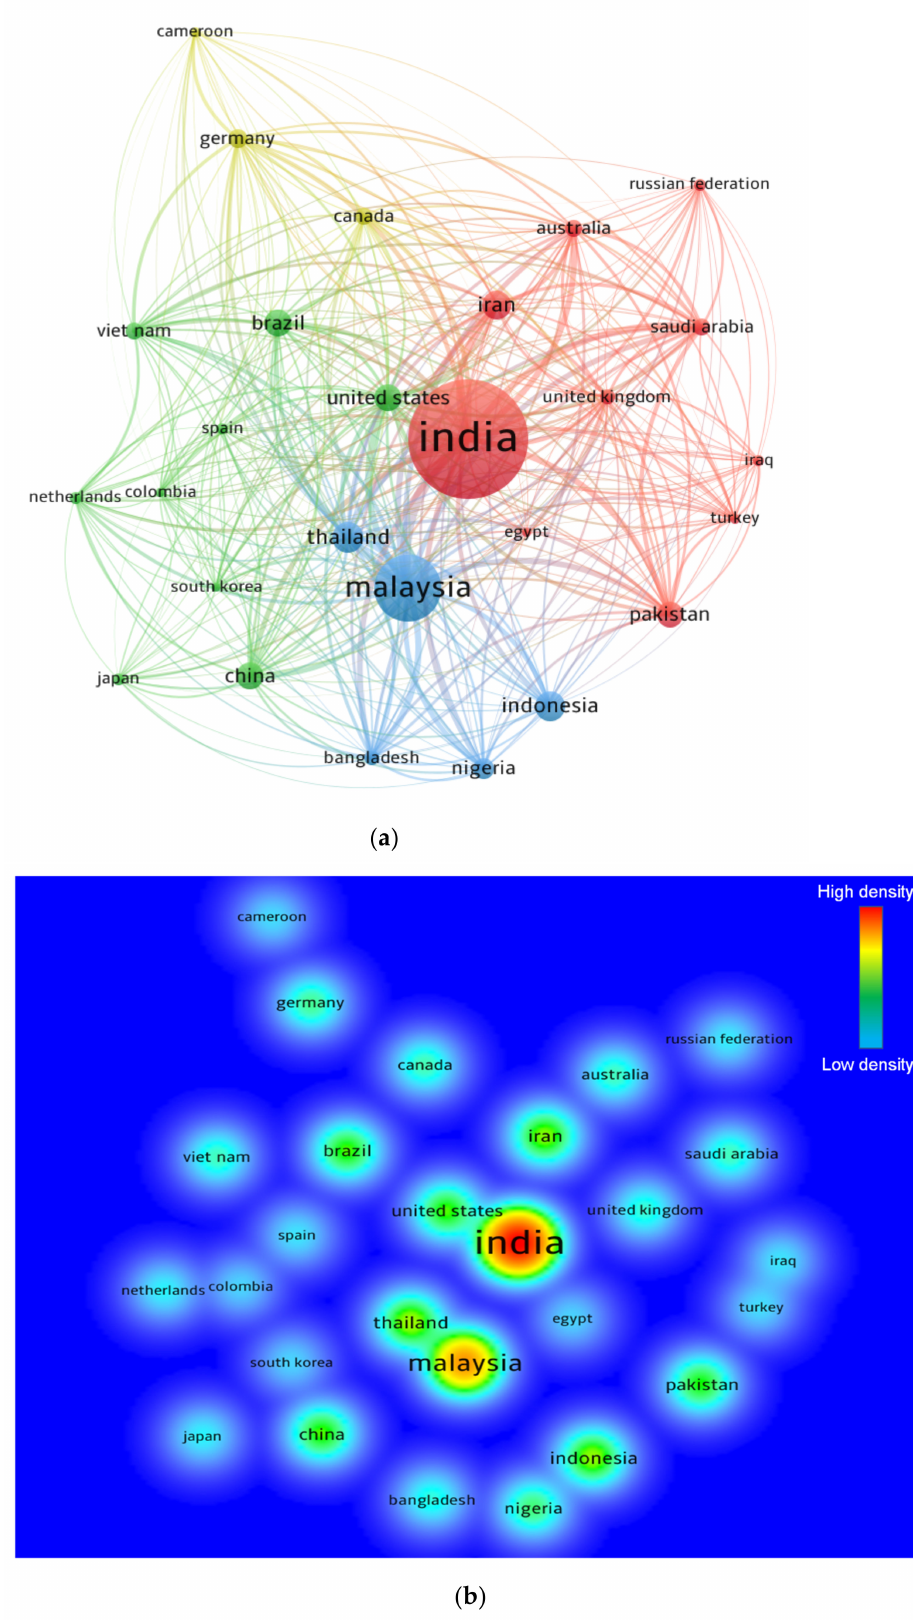
Figure 10. Scientific visualization countries with at least ten publications in the related research area up to 2021: ( a ) network visualization; ( b ) density